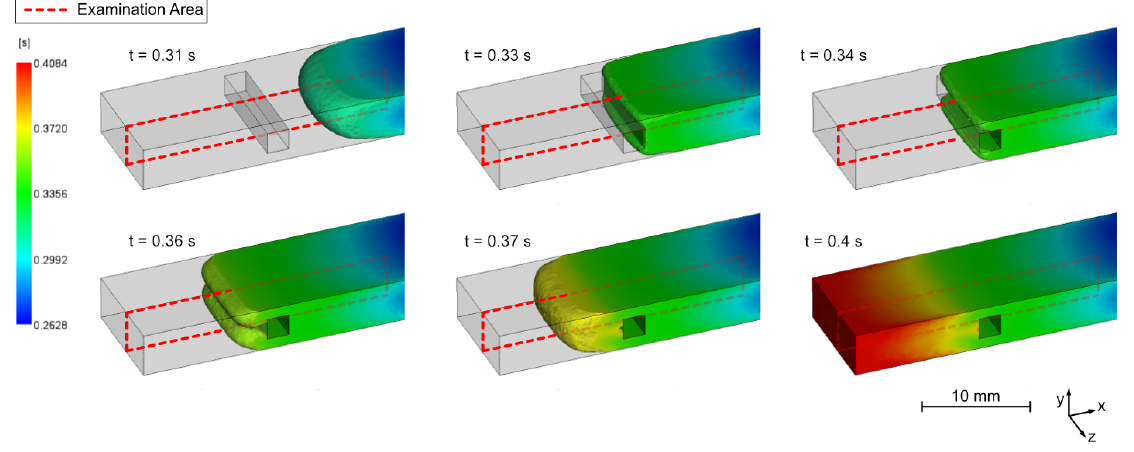
Figure 7. Melt flow obtained from injection molding simulation in the pin area showing the division of the melt front and the formation of the weld line after passing the pin.